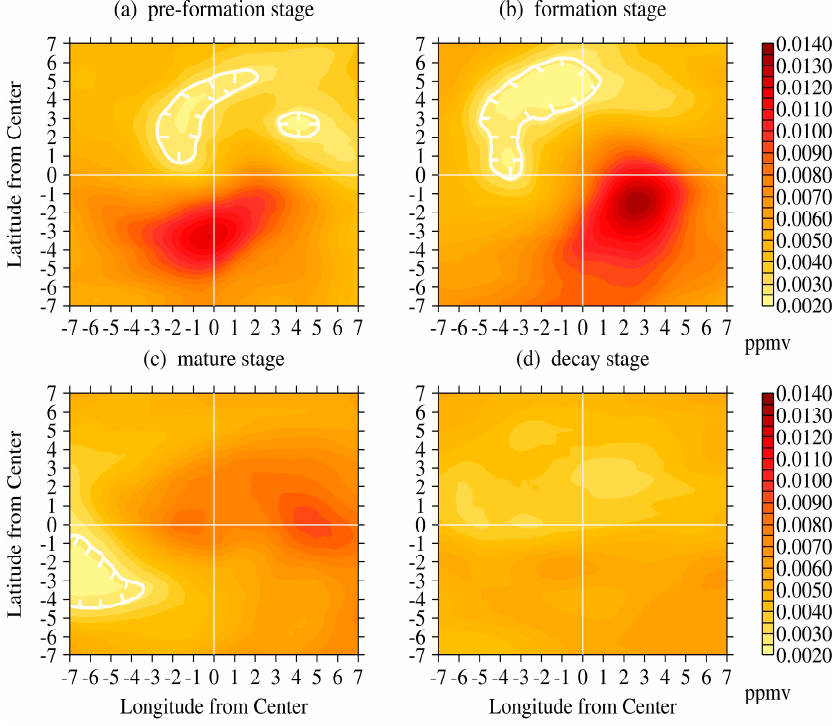
Figure 6. Same as Figure 5, but for 500 hPa.